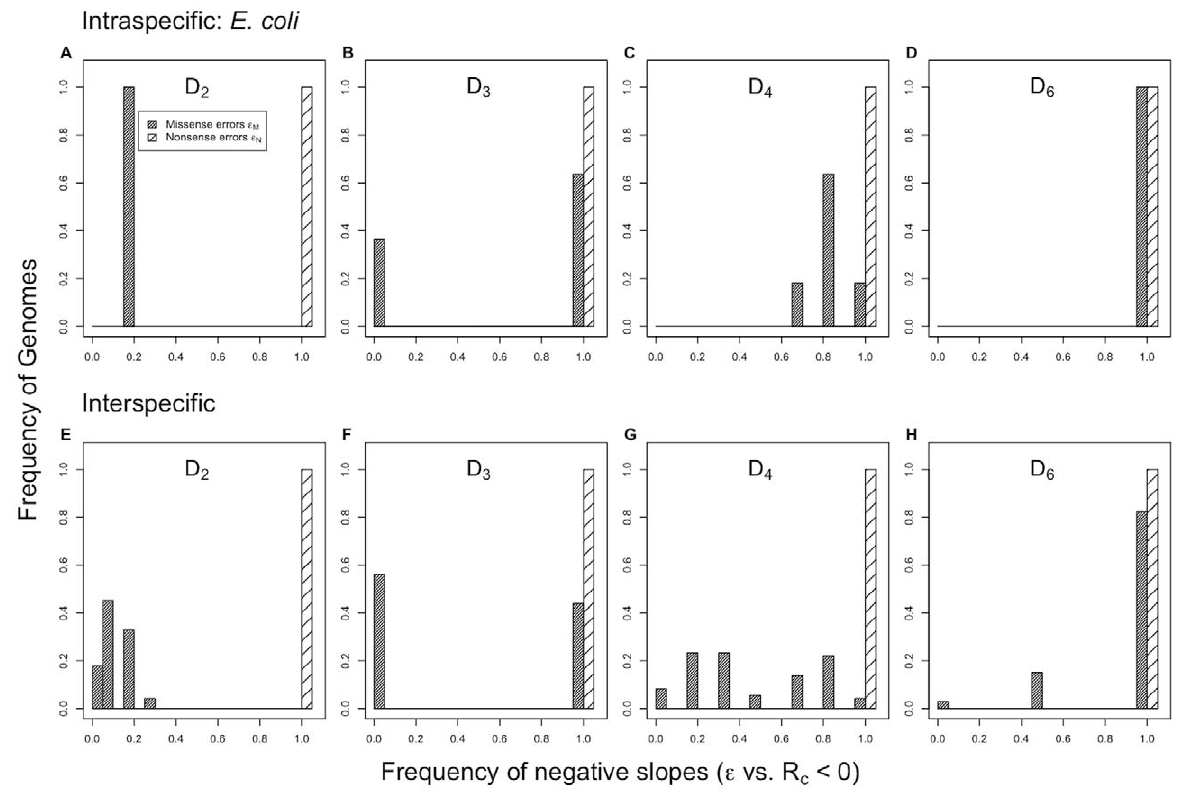
Figure 4. Frequencies of negative relationships between cognate elongation rate R c and translation errors e . Panels (A–D) represent the distribution of E. coli strains that show amino acid specific negative relationship between R c and e , while panels (E–H) represent the distribution of 73 genomes for the same. Amino acids in every degenerate class ( D i ) show a negative relationship between cognate elongation rate R c and nonsense error rates ( e N ) both intra-specifically as well as inter-specifically. A majority of amino acids in the 2-fold degenerate class ( D 2 ) show an increase in missense error rate e M with R c across genomes. As the degeneracy of amino acids increases, we see an increase in the frequency of the expected negative relationship between e M and R c across E. coli strains as well as other bacterial